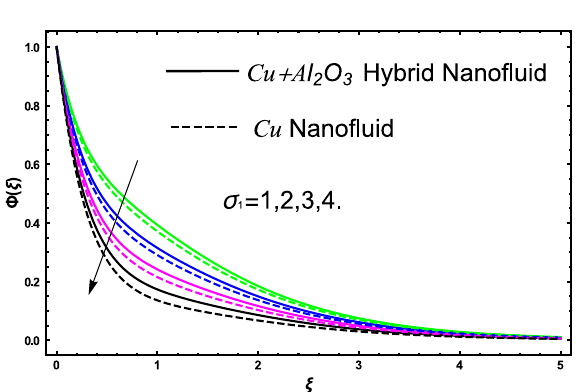
Figure 12. The fluctuation of concertation φ(ξ) versus extended values of σ 1